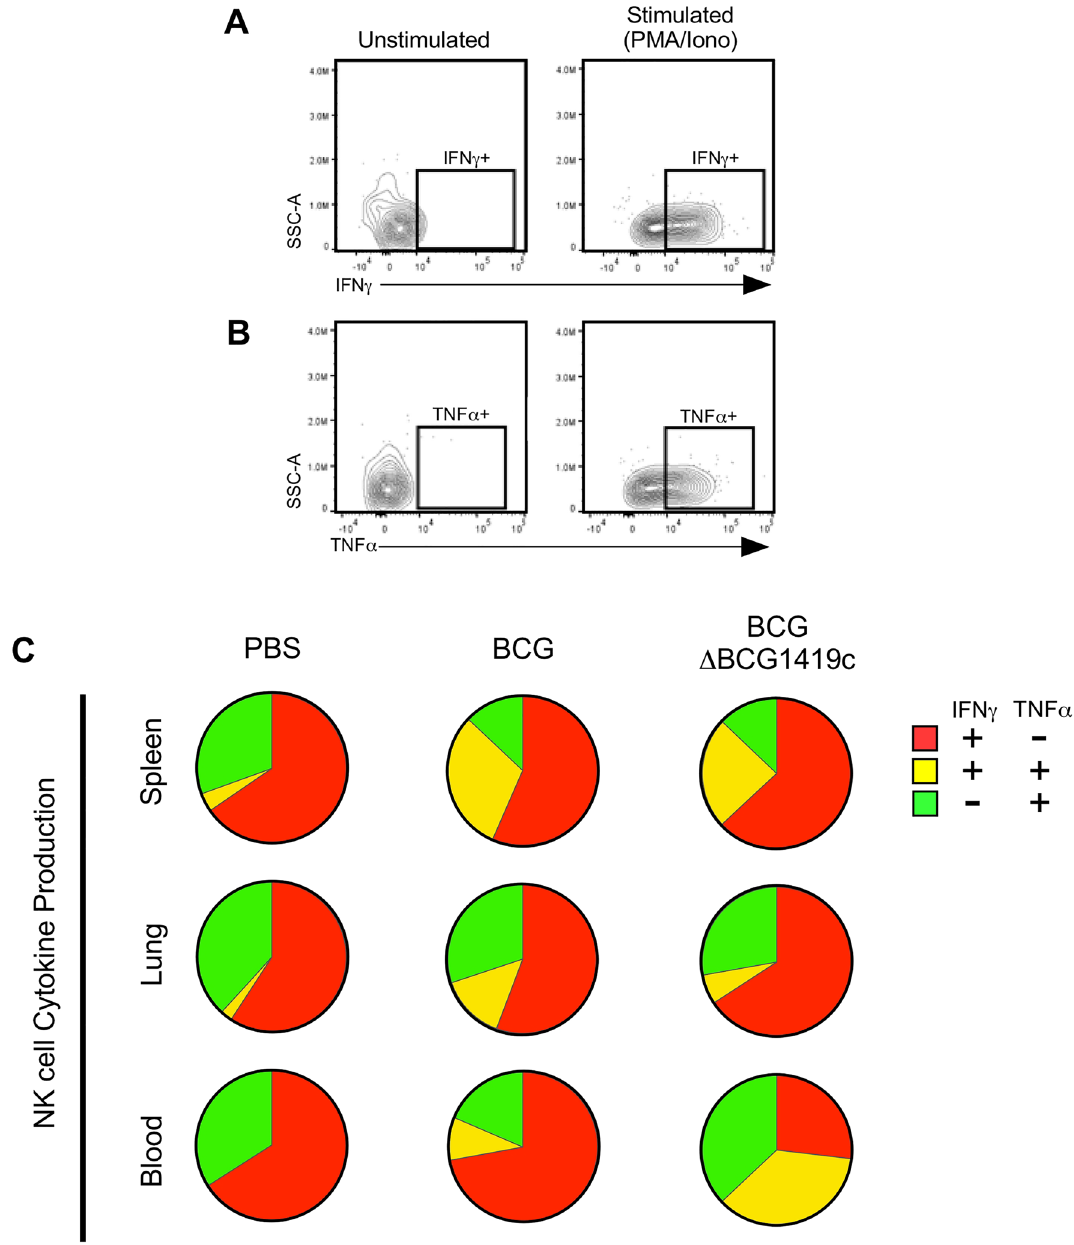
Figure 7. NK cell cytokine production in BCG- and BCGΔBCG1419c-immunized mice. C57BL/6 mice were s.c. immunized with 10 4 CFU of either BCG or BCGΔBCG1419c, or PBS as a control; 18 days later, mononuclear cells from the spleen, lung and blood were prepared and used for intracellular cytokine staining, following stimulation with PMA/Ionomycin. Shown are ( A ) representative IFNγ staining and ( B ) representative TNFα staining of unstimulated and stimulated mononuclear cells, gated off NK cells; ( C ) Spice analysis of single positive (IFNγ + and TNFα + ) and double positive (IFNγ + TNFα + ) NK cells in the spleen, lung and